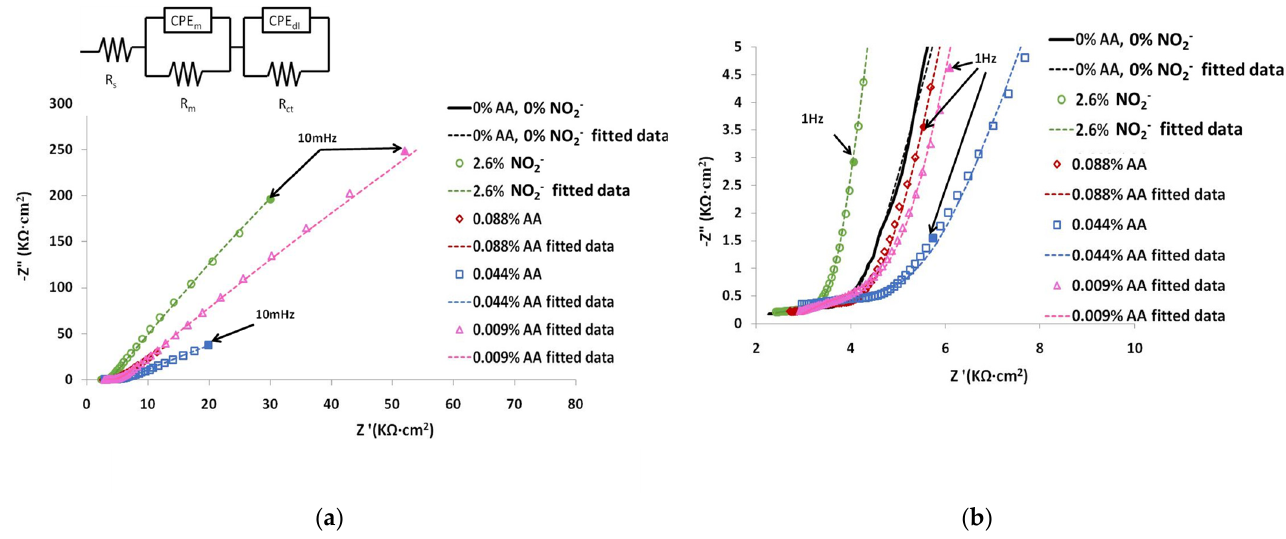
Figure 5. ( a ) Nyquist plots of chloride-contaminated mortars, 2% of Cl − with 0.088, 0.044 and 0.009% of AA and 2.6% of NO 2 − and equivalent circuit; ( b ) amplified view.